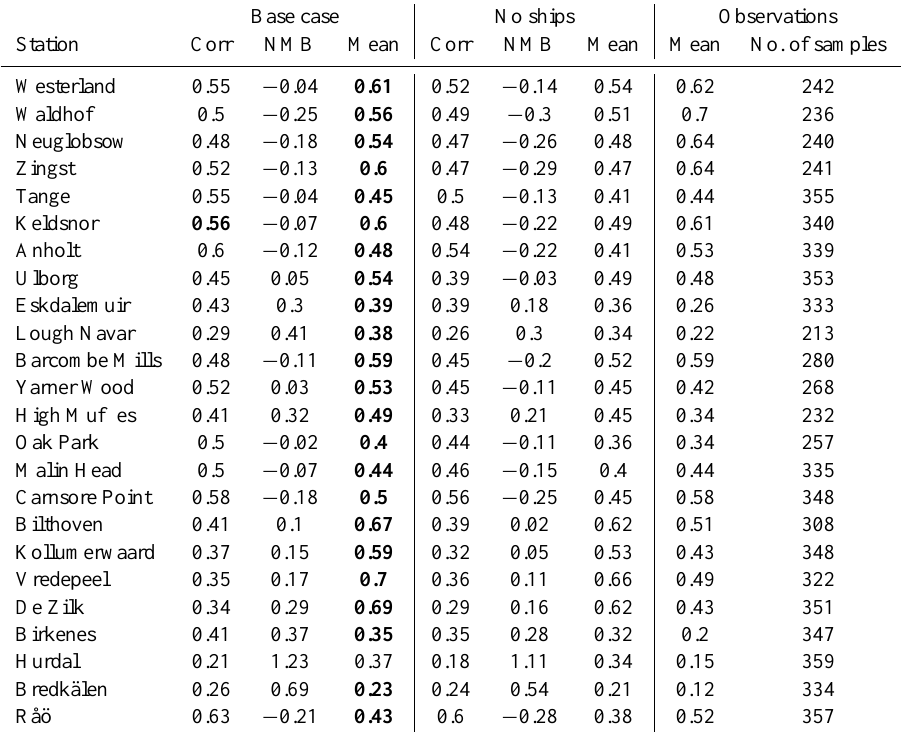
Table 9. Comparison of simulated SO 2 − concentrations with observations in µgm − 3 . Values that are significantly different between the base 4 case and the no-ships case are printed in bold.